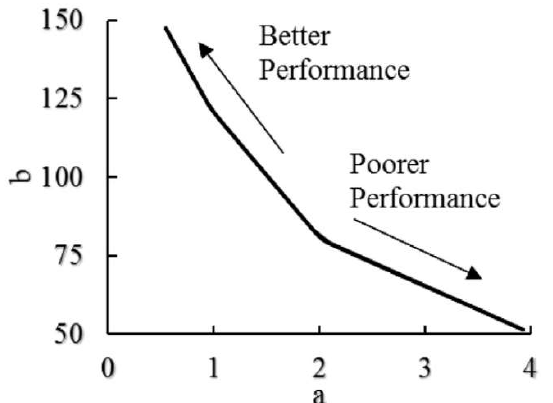
Figure A1. The relation between two recommended floor vibration parameters, a and b , according to Eurocode 5. Reproduced from [53] with permission.